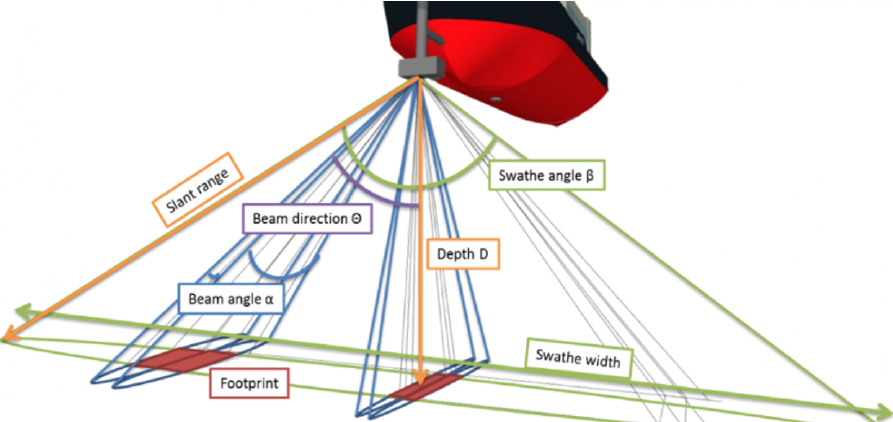
Figure 1. Parameters of a Multi-beam Sonar